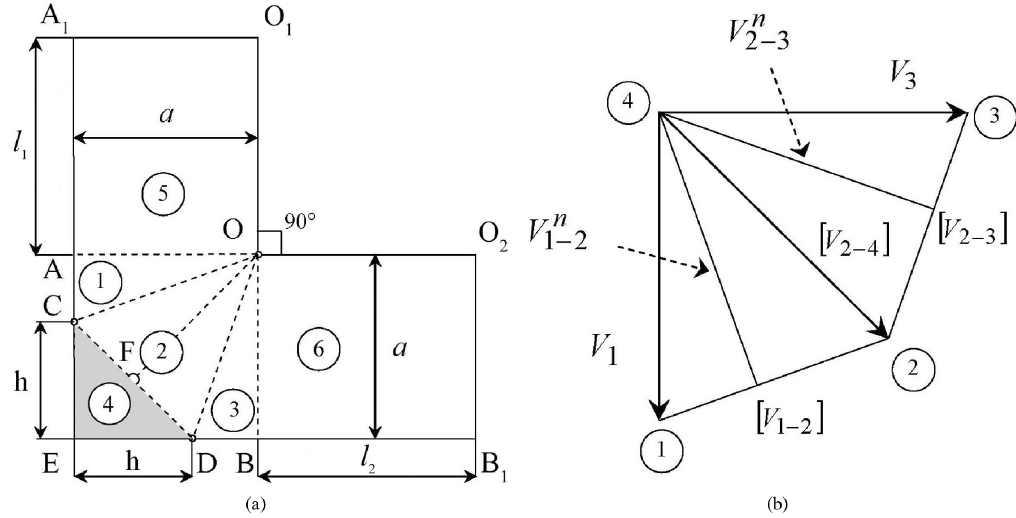
Figure 2. Partitioning of ECAE sample into rigid blocks (a) and corresponding velocities hodograph (b).